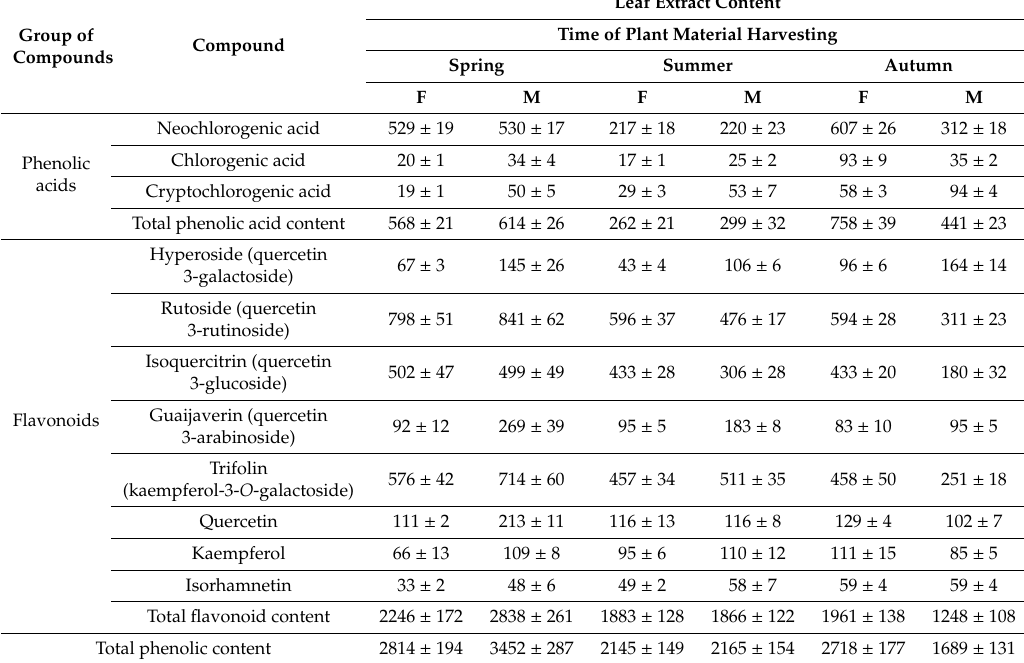
Table 4. The content (mg / 100 g DW ± SD) of main detected phenolic compounds of S. rubriflora leaf extracts (F—female; M—male) ( n = 5, p <